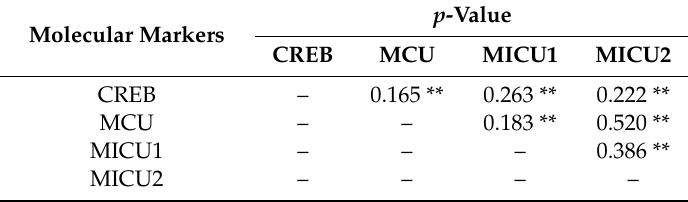
Table 2. Correlations among the total scores of CREB, MCU, MICU1, and MICU2 in HCC tissues. p Molecular Markers